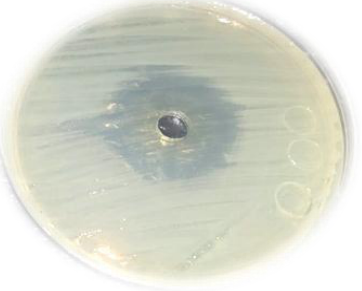
Figure 1 : Activity of Cell- Free Supernatant of S. sanguinis SH3 against Enterococcus faecalis